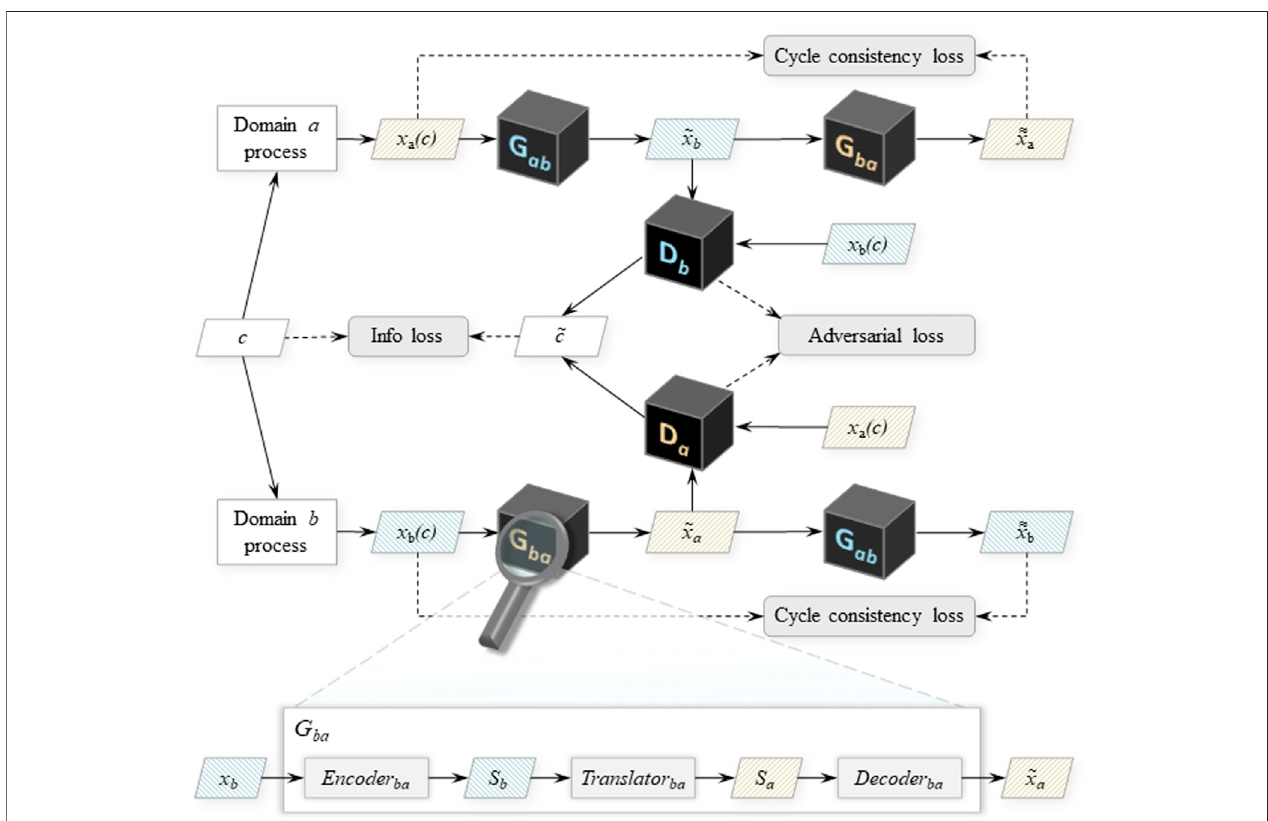
FIGURE 5| Conditional CycleStyleGAN architecture. G ab and G ba denote the generator networks thattranslate signals from domain a to domain b and vice versa. D a and D b arethediscriminatorsthatprocessdomain a and b signals,bothrealandtheonestranslatedintotheirrespectivedomain.Thecalloutonthebottomshowsthe subnetworks of G , using G ba as the example. Other notation: c , ~ c — real and estimated process parameter values; x a ( x b ) — true domain a ( b ) signals; ~ x a ( ~ x b ) - signals ≈ ≈ synthesised via translation to domain a ( b ); x a ( x b ) — signals synthesised via reconstruction back to domain a ( b ); S a ( S b ) — style encoding of a domain a ( b ) signal. The different colour coding indicates the data structures and the neural networks associated with each